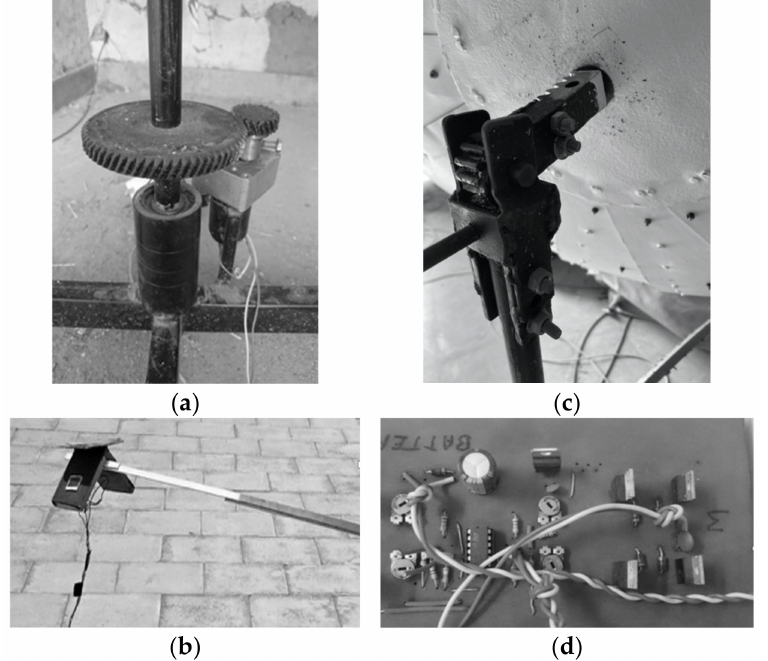
Figure 3. ( a ): Azimuthal tracking. ( b ): LDR arrangement. ( c ): Elevation tracking. ( d ): Tracking